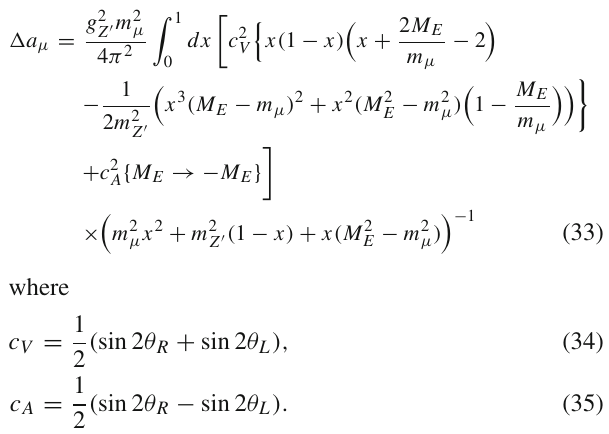
SM value becomes